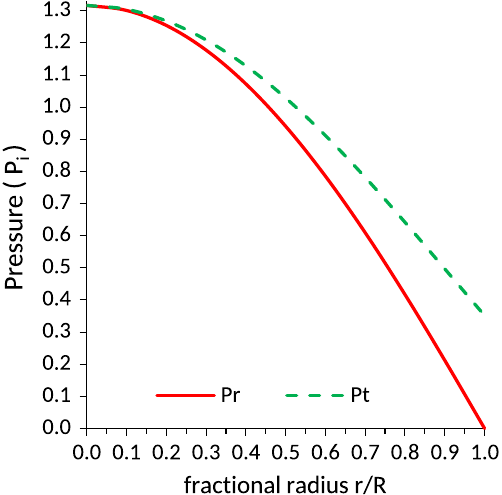
Fig. 3 Behavior of the effective radial and tangential pressures P r = 8 π p r / C and P t = 8 π p t / C withrespecttothefractionalradialdistance r / R for RX J 1856-37. For plotting this figure we have employed the same data set of numerical values as used in Figs. 1 and 2